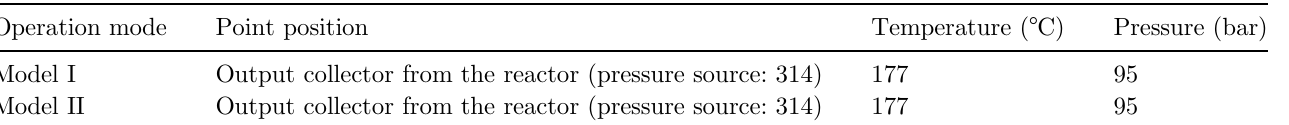
Table 1. Boundary conditions for the hydraulic